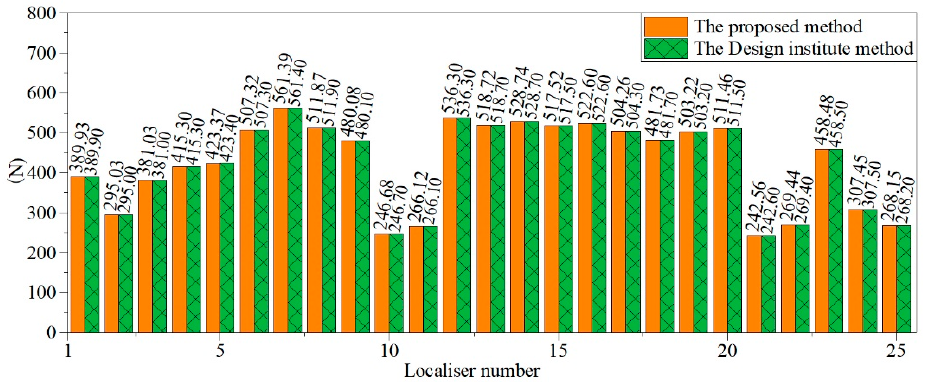
Figure 9. Zigzag force calculation result.